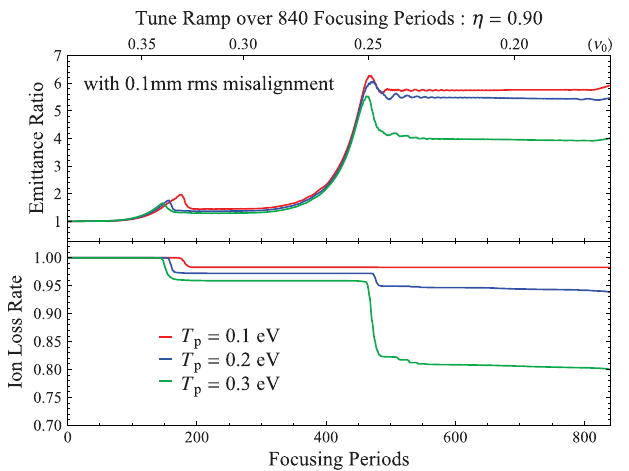
FIG. 7. Results of ion-loss simulations with the WARP code. The input parameters are identical to those assumed in Fig. 6(d), except for the initial plasma temperature T p . The rms misalign- ments of the electrodes have been set at 0.1 mm. The ordinate of the lower panel represents the number of ions surviving, divided by its initial value. We here consider T p ¼ 0 : 1 , 0.2, and 0.3 eV, recalling previous experimental data [24]. To simulate ion losses in actual experiments, macroparticles that have gone across the electrode boundaries are just removed. The observed T p depen- dence of emittance evolution is caused largely by the macro- particle